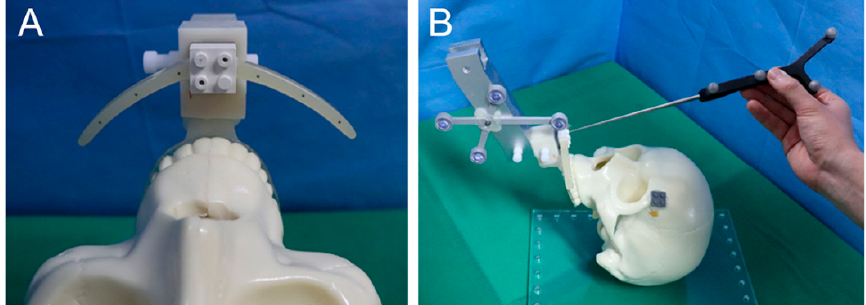
Figure 3. Preoperative registration for matching the physical space and the CT image space. ( A ) Registration body; ( B ) acquisition of the physical positions of spheres on the registration body related to the tracking tool on the end-effector.